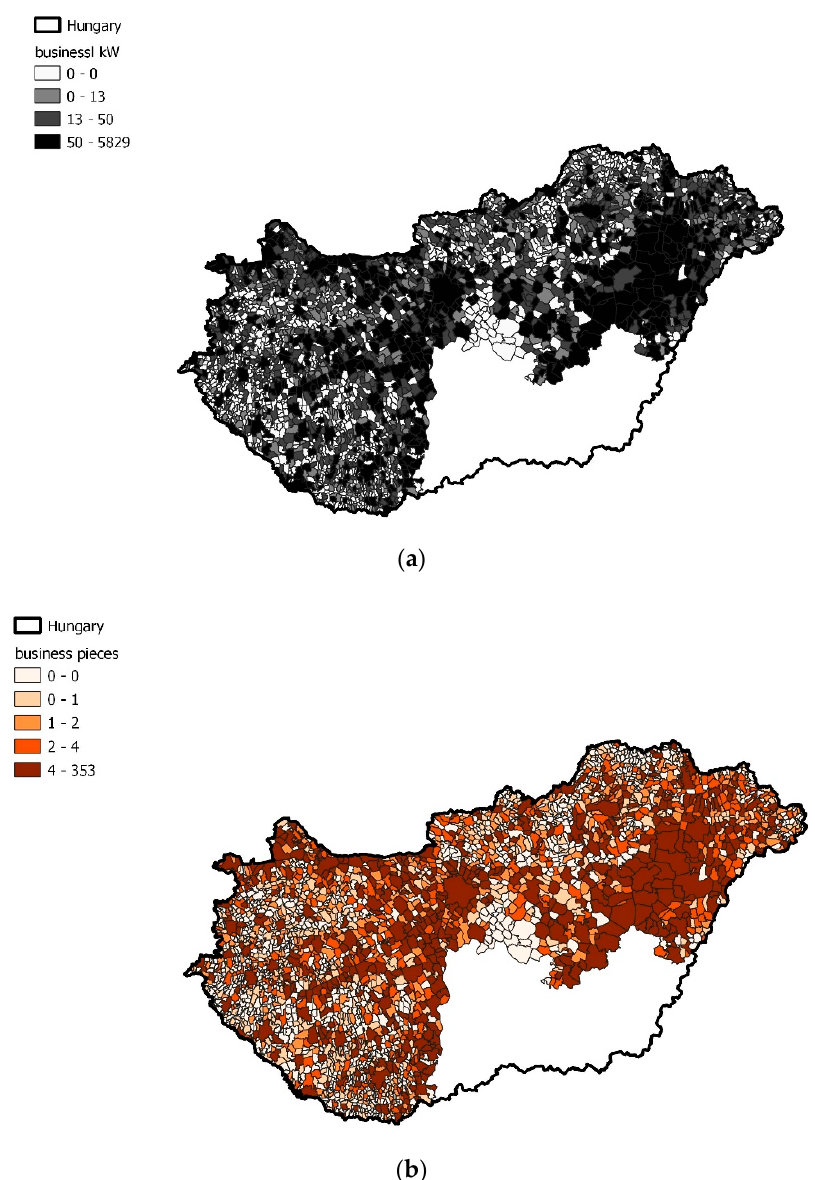
Figure 5. Total business HMKE power ( a ) and the number ( b ) of business HMKEs in the settlements of Hungary.